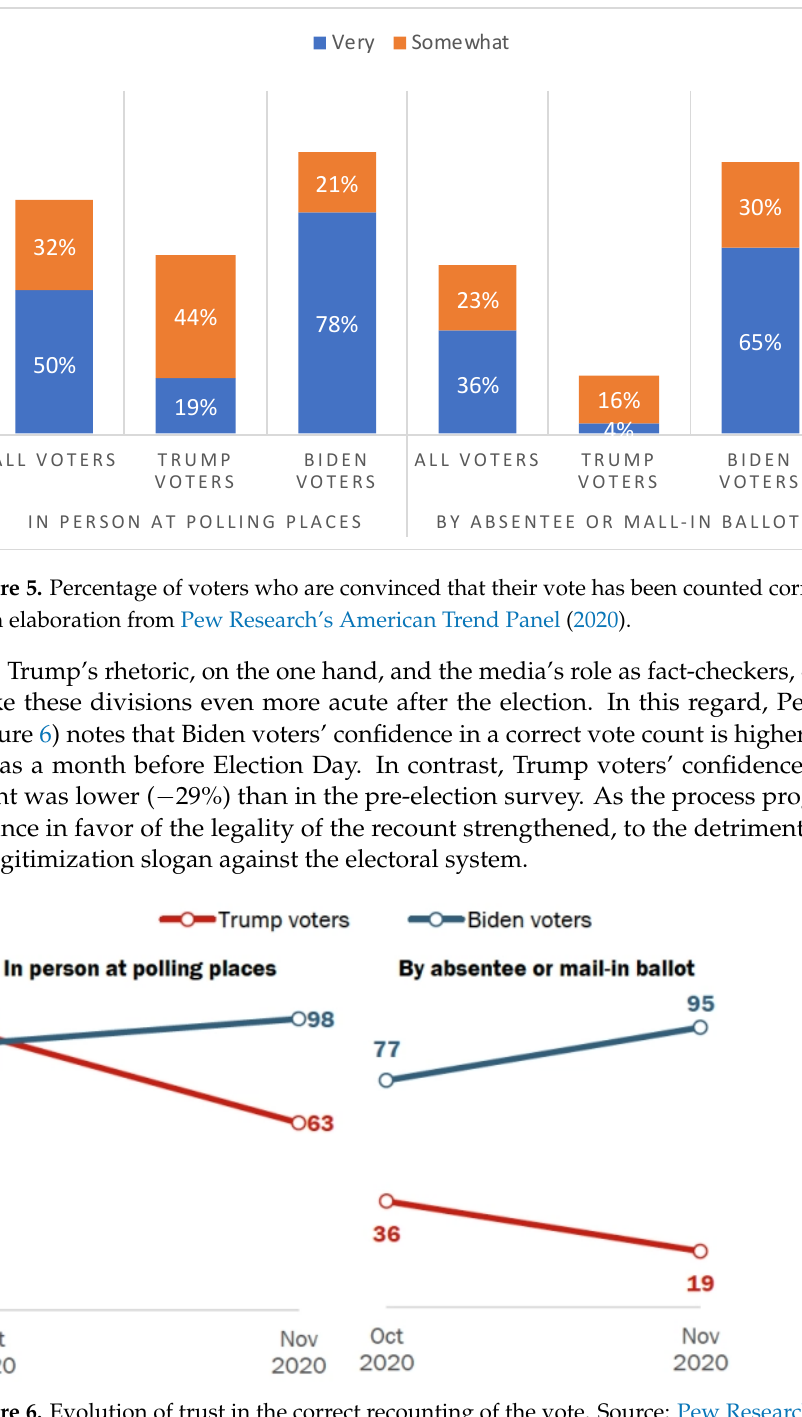
9 Figure 4. Percentage of voters who believe that the U.S. elections have been well managed. Source: Own elaboration from Pew Research’s American Trend Panel (2020).